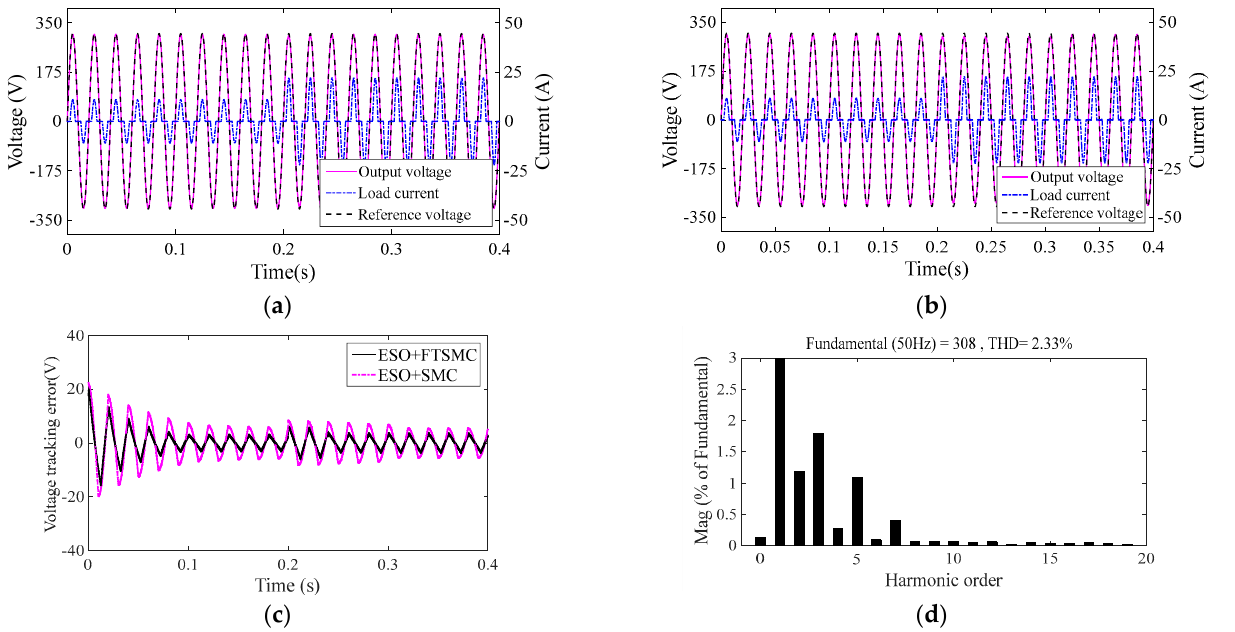
Figure 8. Inverter system output response under nonlinear load saltation: ( a ) output response of System 1, ( b ) output response of System 3, ( c ) voltage error, ( d ) output voltage THD of System 1.